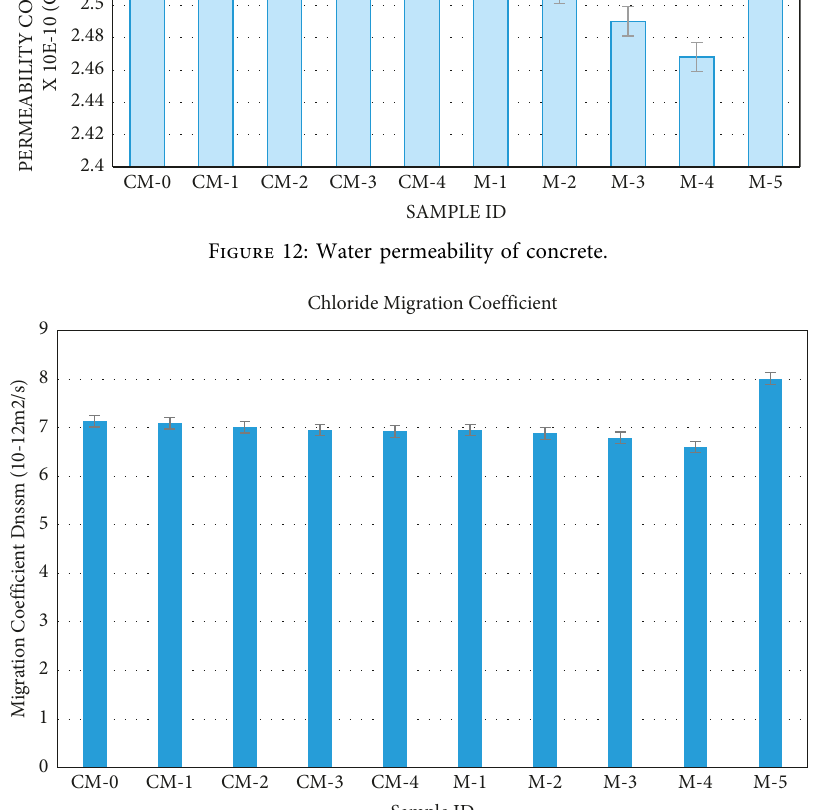
Figure 13: The values of chloride migration